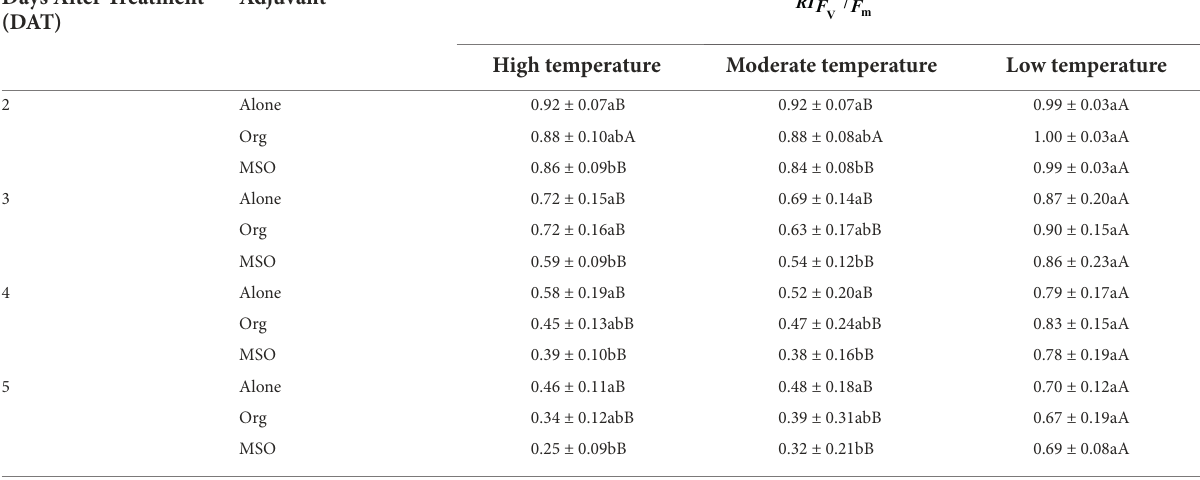
TABLE 3 Effects of two adjuvants on the maximum quantum efficiency (F v /F m ) of velvetleaf (Abutilon theophrasti Medik.) at 2–5 days after treatment (DAT). Days After Treatment